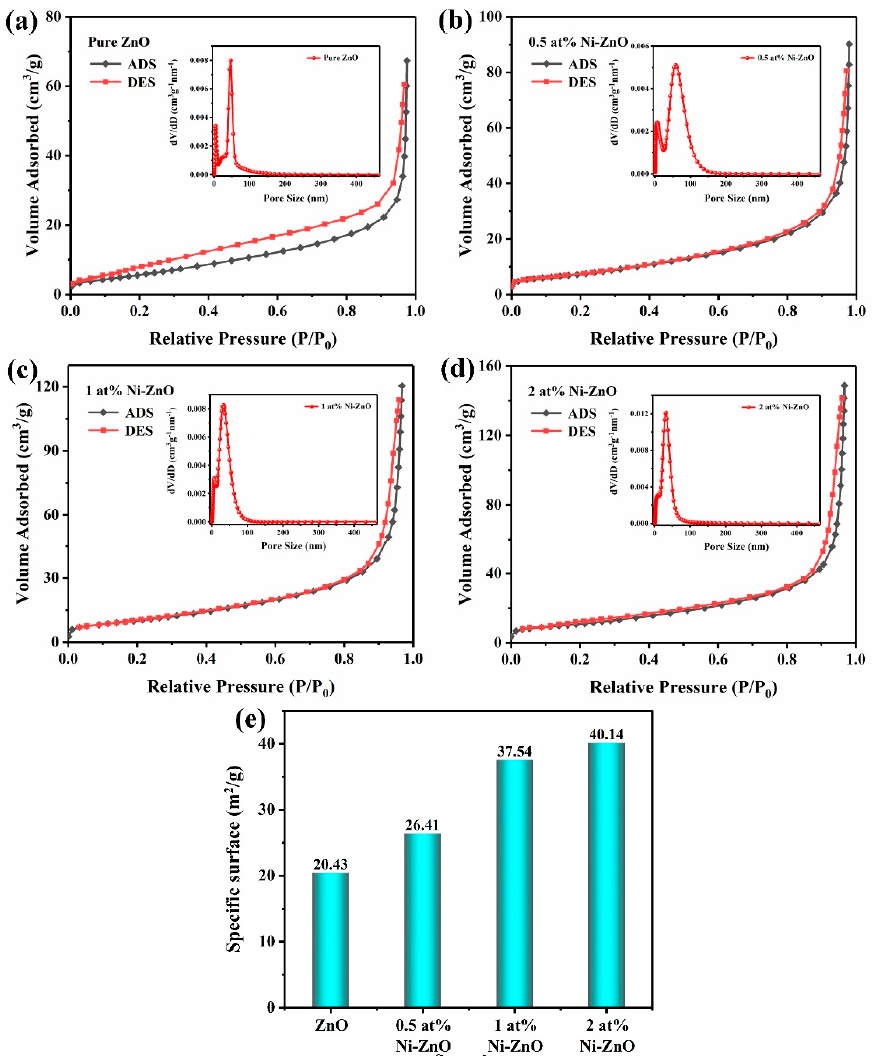
Figure 4. The nitrogen absorption–desorption isotherms and pore size distribution curves (inset) of the ( a ) pure ZnO and ( b ) 0.5 at% ( c ) 1 at%, and ( d ) 2 at% Ni–ZnO. ( e ) Specific surface area of the samples.